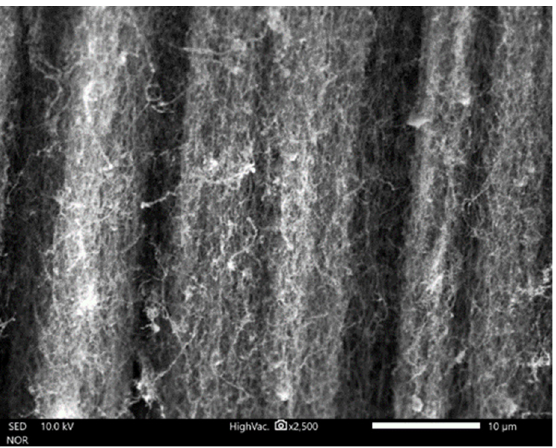
Figure 2. Magnification of a side of the “carpet” showing multiple entangled bundles—SEM